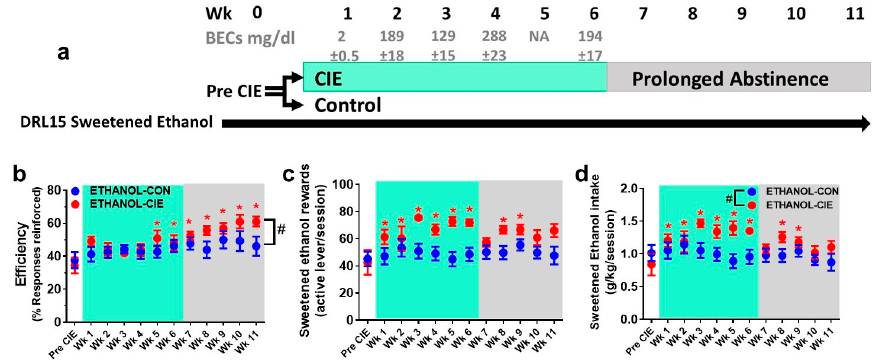
Table 1. Body weights of rats did not differ between groups.